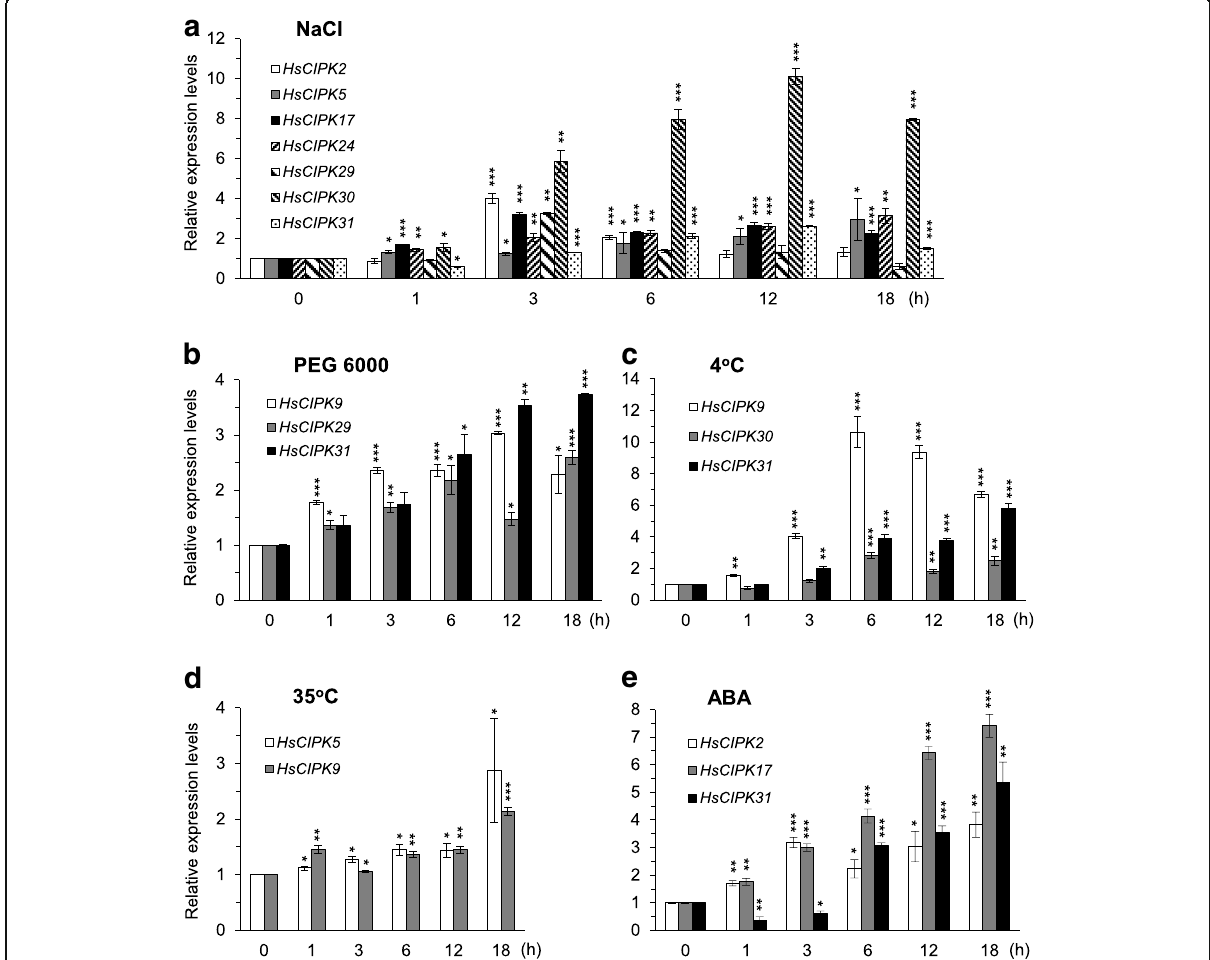
Fig. 4 Salt-, drought-, temperature-, and ABA-induced expression patterns of HsCIPKs . a-e Relative expression levels of HsCIPKs in four-day-old wild barley seedlings treated for different time lengths (0, 1, 3, 6, 12, and 18 h) with 400 mM NaCl ( a ), 20% PEG 6000 ( b ), 4 °C ( c ), 35 °C ( d ), and 20 μ M ABA ( e ), respectively. Values shown are means ± SD. Single, double, and triple asterisks indicate P < 0.01, 0.001, and 0.0001, respectively ( t test; compared to the corresponding 0-time point mock control). The expression level of the 0-time point mock control for each HsCIPK was set as